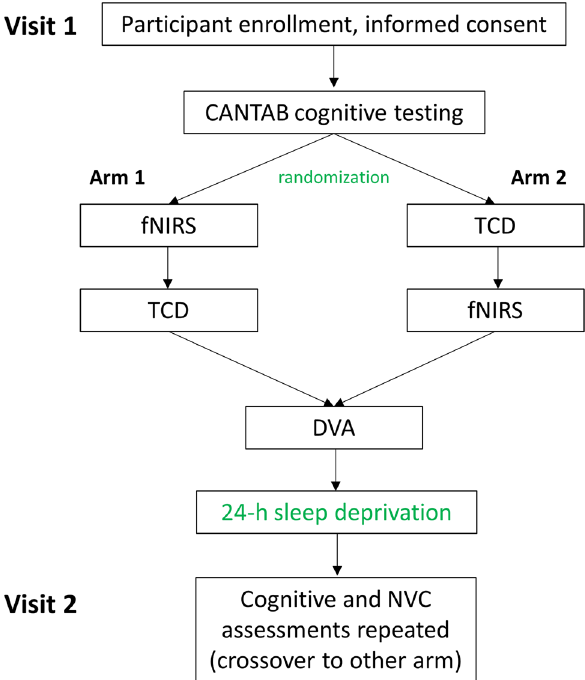
Figure 1. Flowchart showing the study protocol. CANTAB: Cambridge Automated Neuropsychological Test Automated Battery, TCD: Transcranial Doppler sonography, fNIRS: functional Near-Infrared Spectroscopy, DVA: Dynamic retinal Vessel